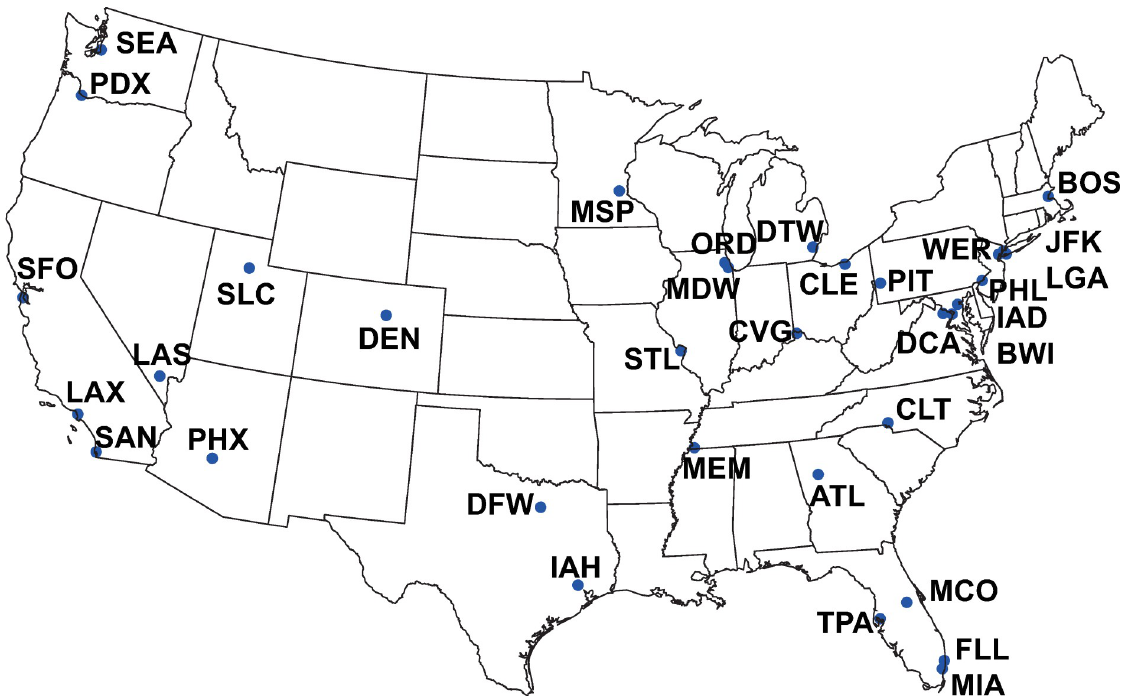
Fig 2. The busiest 34 airports in the United States of America. The map was created by Python 3.6 with the help of free vector and raster map data from Natural Earth (http://www.naturalearthdata.com/) and the location data of airports from BTS (https://www.bts.gov/).